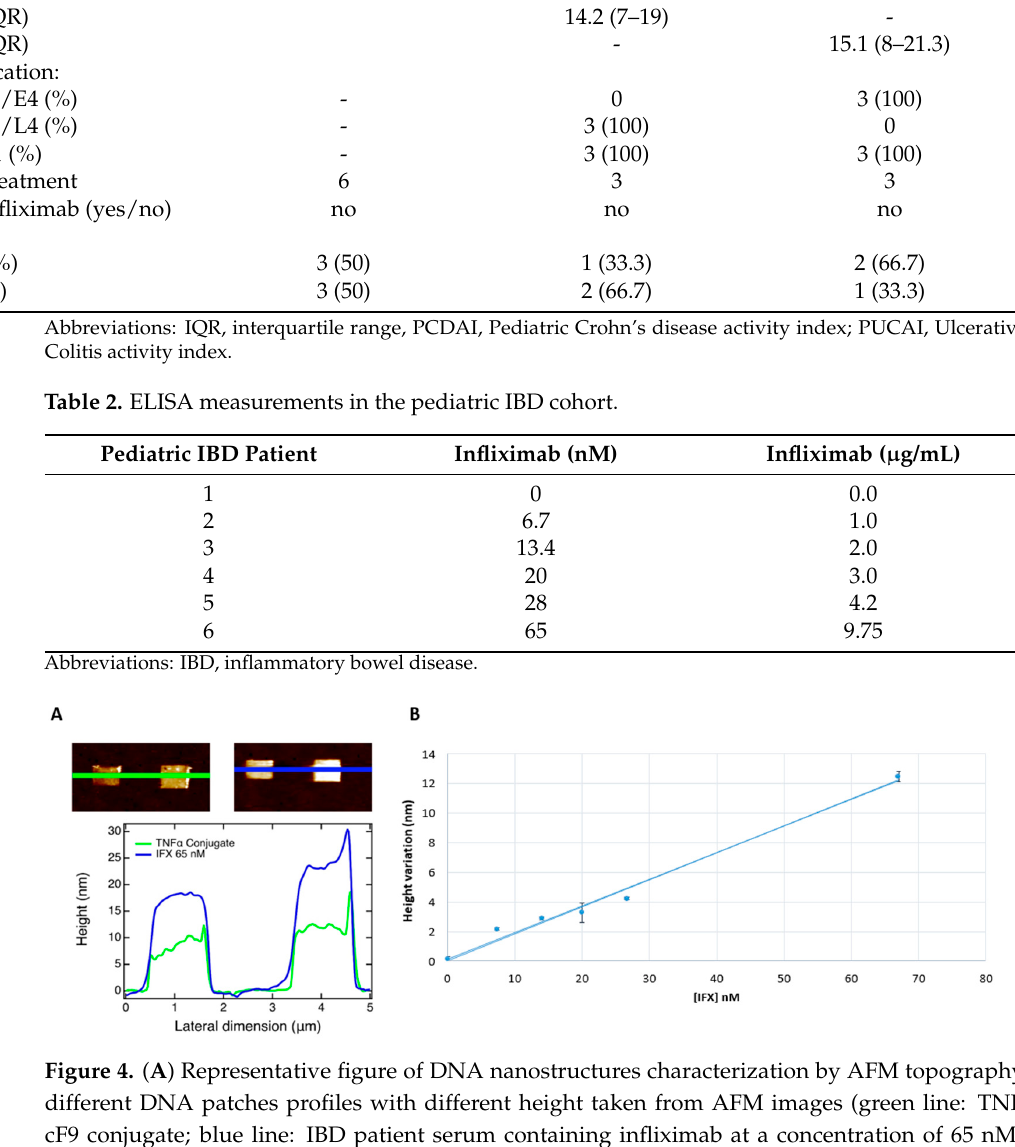
Table 1. Demographic and clinical characteristics of the IBD population enrolled. Abbreviations: IQR, interquartile range, PCDAI, Pediatric Crohn’s disease activity index; PUCAI, Ulcerative Colitis activity index.